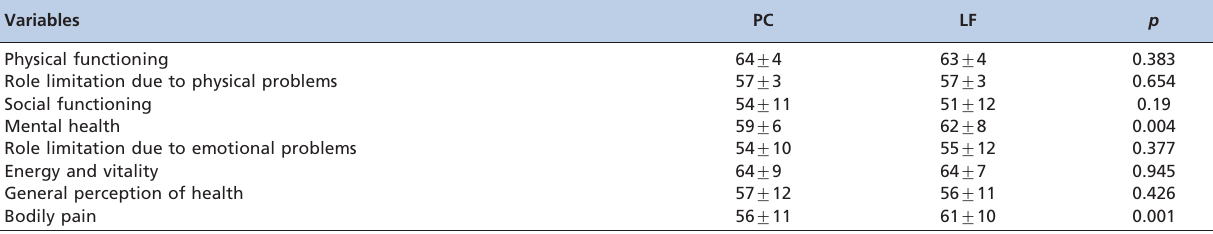
Table 1 - Comparison of Short Form 36 scores between groups.